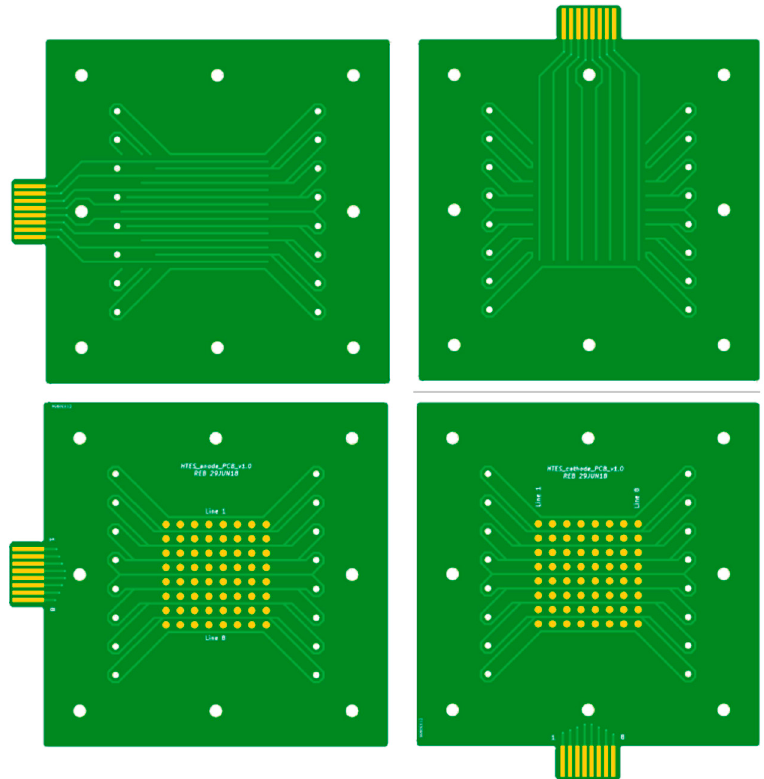
Figure 11. Back (top row) and front (bottom row) copper of the anode (left column) and cathode (right column) PCBs. The connections on the side of the PCBs are connected from the back with a ‘via’ underneath each circular electrode. On the front side, copper traces are used to mark the fluidic channels and to form a seal with the PTFE gaskets by protruding out of the PCB surface by 70 µ m (the copper thickness). On the back side, these traces are repeated so that additional force is applied by the stainless steel end plates onto the sealing surfaces. Eight mounting holes are located at the corners and halfway each edge.